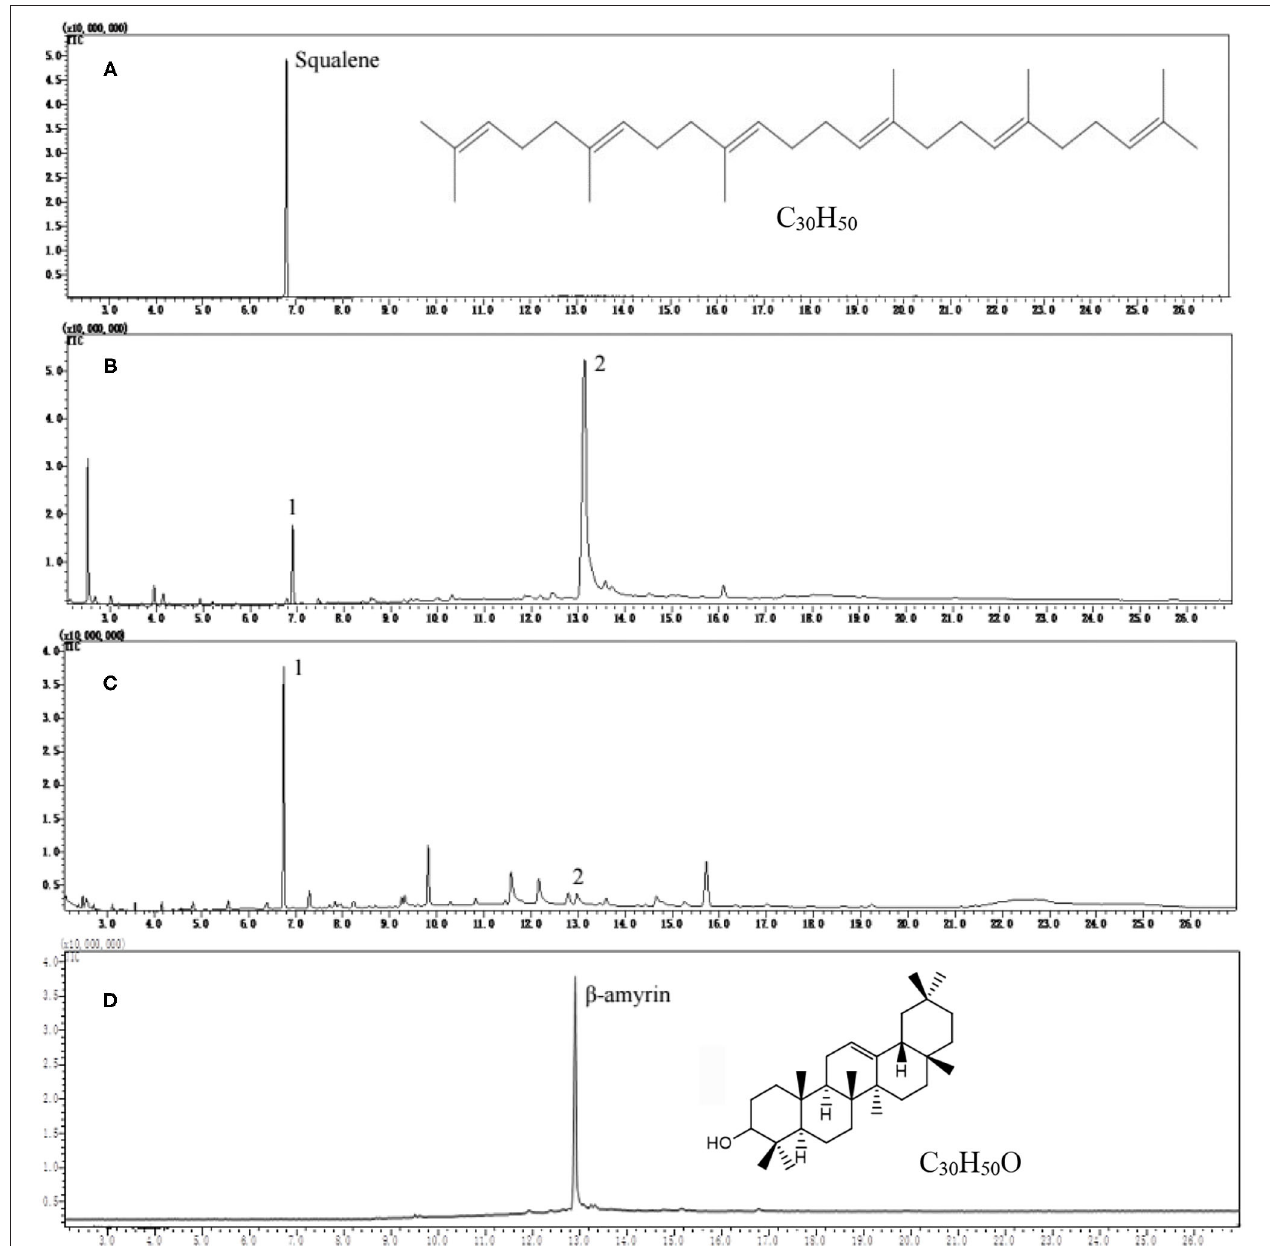
FIGURE 1 | Gas chromatography (GC) profiles of squalene reference, tea leaf extracts, and β -amyrin reference. (A) Squalene reference, (B) tea extract after saponification, (C) tea extract before saponification, and (D) β -amyrin reference.